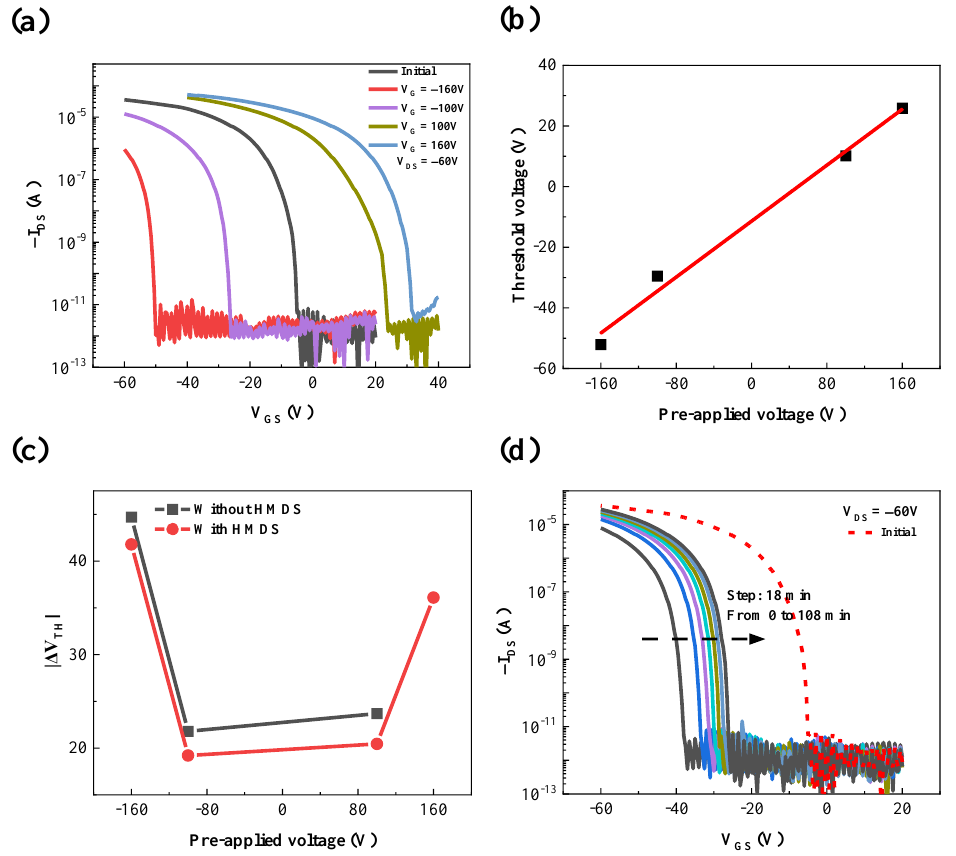
Figure 3. ( a ) Transfer curves of different pre-applied gate voltages after the device was treated with HMDS; ( b ) Threshold voltage shift as a function of pre-applied voltage to the gate electrode; ( c ) The relationship of Δ V TH with pre-applied gate voltage with (red line) and without (black line) HMDS modification; ( d ) With a pre-applied − 140 V gate voltage, the transfer curves of the HMDS-treated device with time.